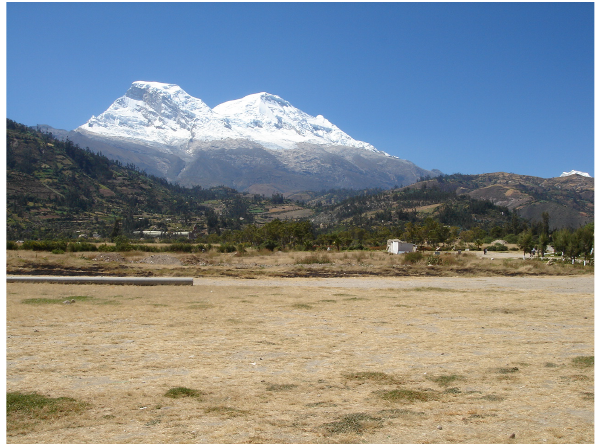
Fig. 1. The Huascar´an, the highest peak in the Peruvian Andes, and its glacier represent both benefit and threat for the local pop- ulation: a massive ice-rock avalanche in 1970 devastated the town of Yungay killing ∼ 20000 residents – melt water from the glaciers are an essential source of freshwater in the dry austral winter. Cli- mate change is likely to alter both the benefit and threat (photo C. Huggel).